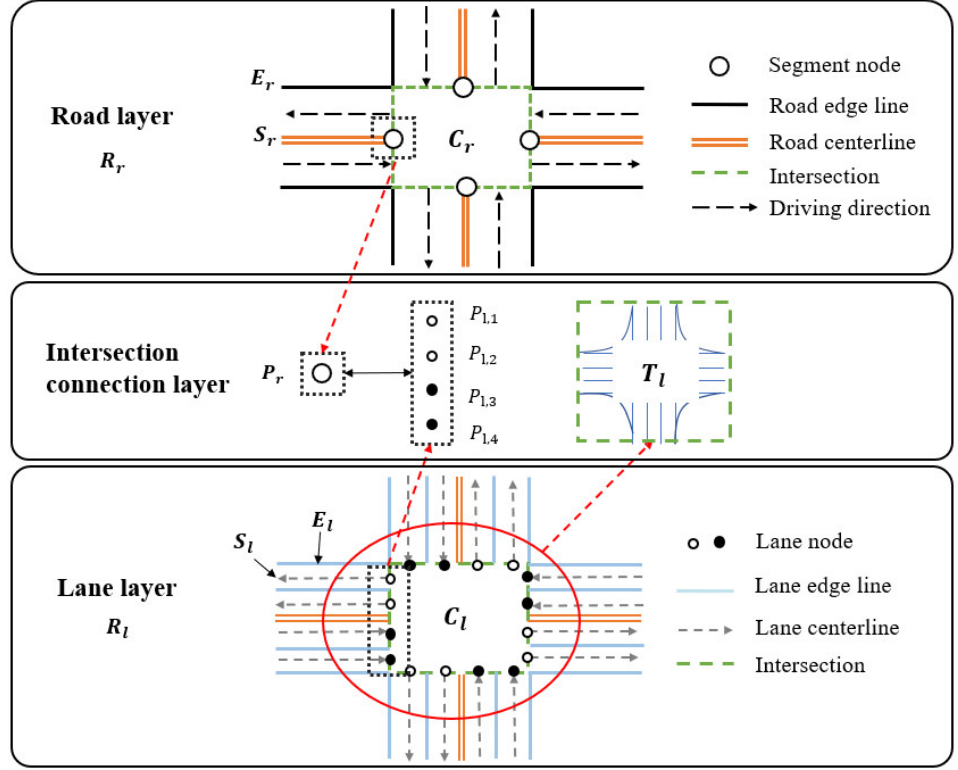
Figure 1. Architecture of the map co nstruction model.